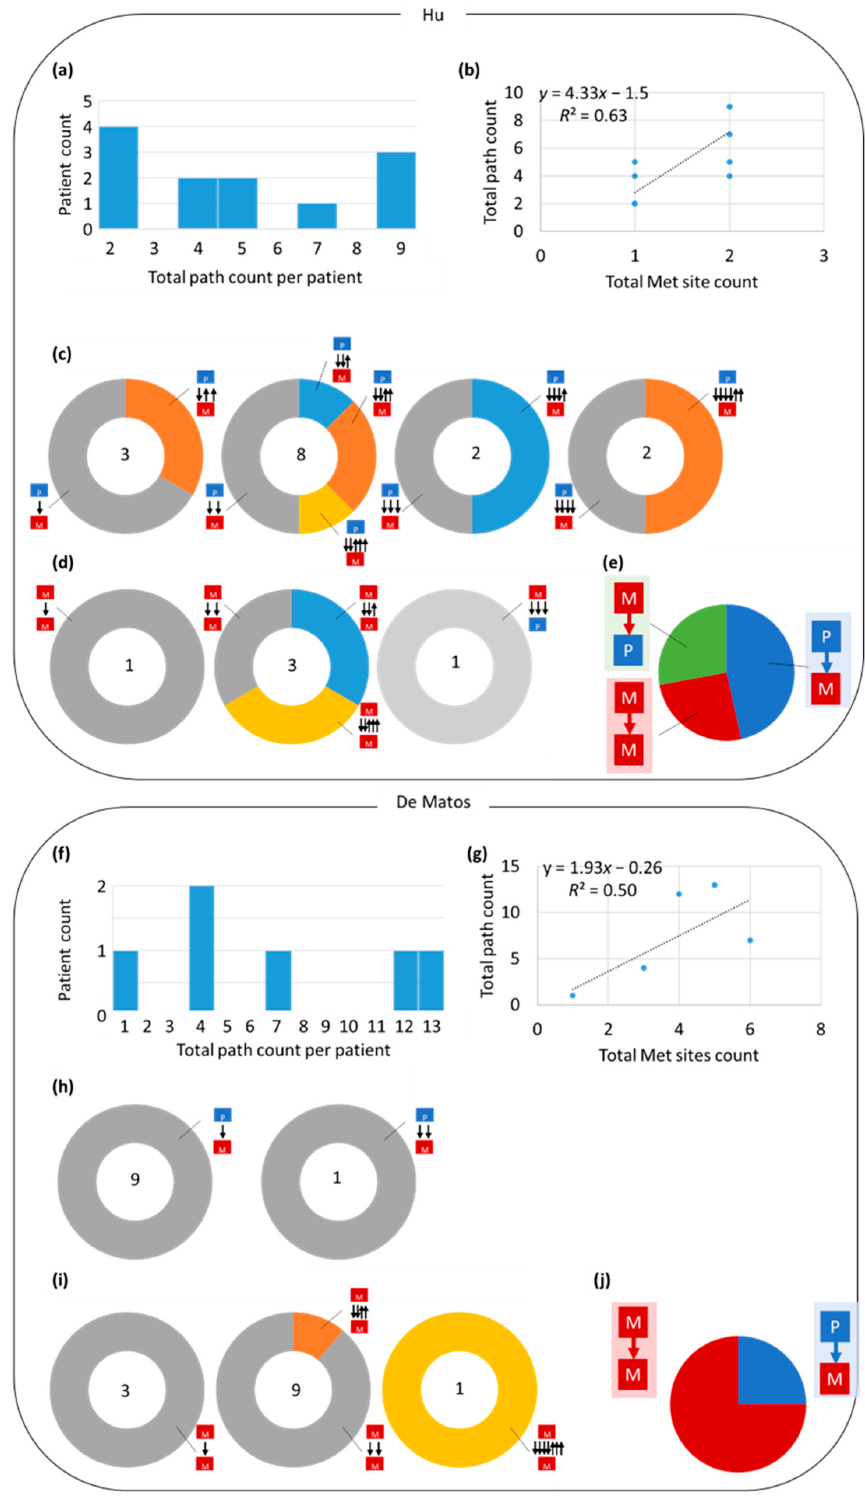
Figure 7. Distribution of clone migrations for the ( a – e ) Hu and ( f – j ) De Mattos cohort datasets ( a , f ) Histograms of migration path counts in patients. ( b , g ) Linear regression of the number of migrations against the number of metastatic sites sampled. ( c , h ) The number (center) and proportions of migrations of clones from primary tumors. ( d , i ) The number (center) and proportions of migrations of clones from metastatic tumors. ( e , j ) Proportions of path types. The De Mattos cohort does not contain primary tumor data, thus there are no M → P paths to